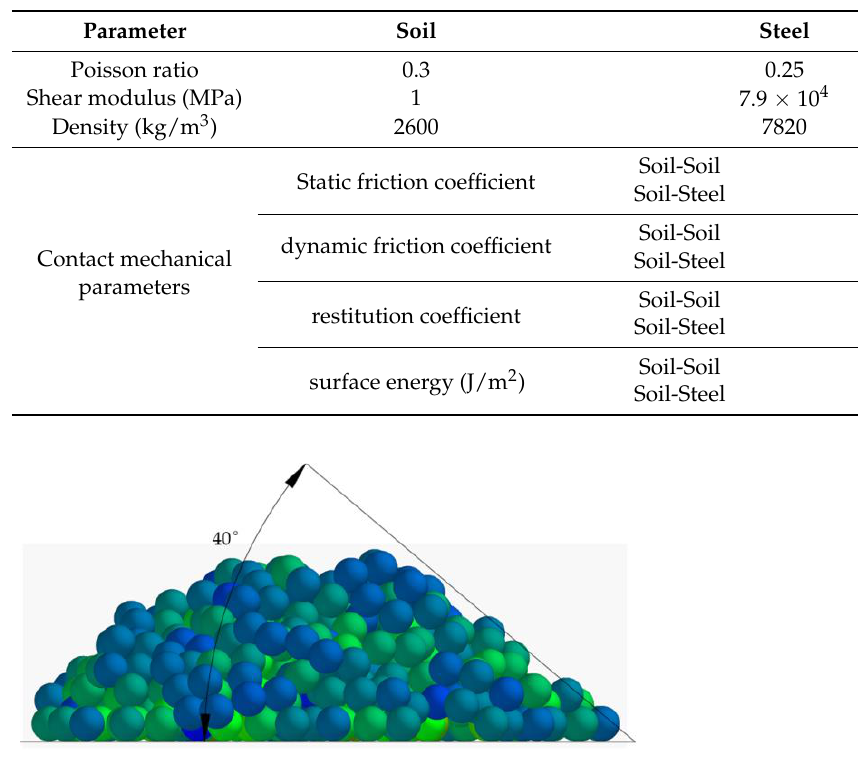
Figure 6. EDEM simulation of angle of repose. Table 1. Parameter table for microscopic discrete element method simulation.